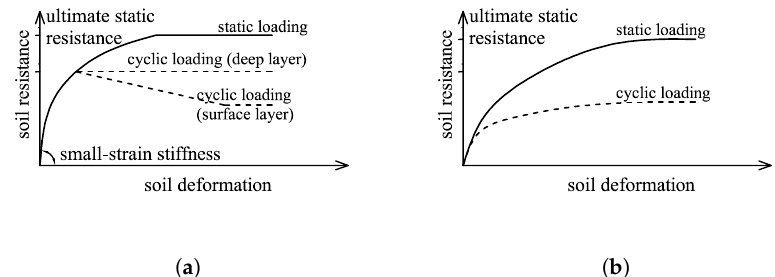
Figure 15. Representations of p − y curves for ( a ) clay and ( b ) sand, distinguishing the soil-structure interaction for static or cyclic